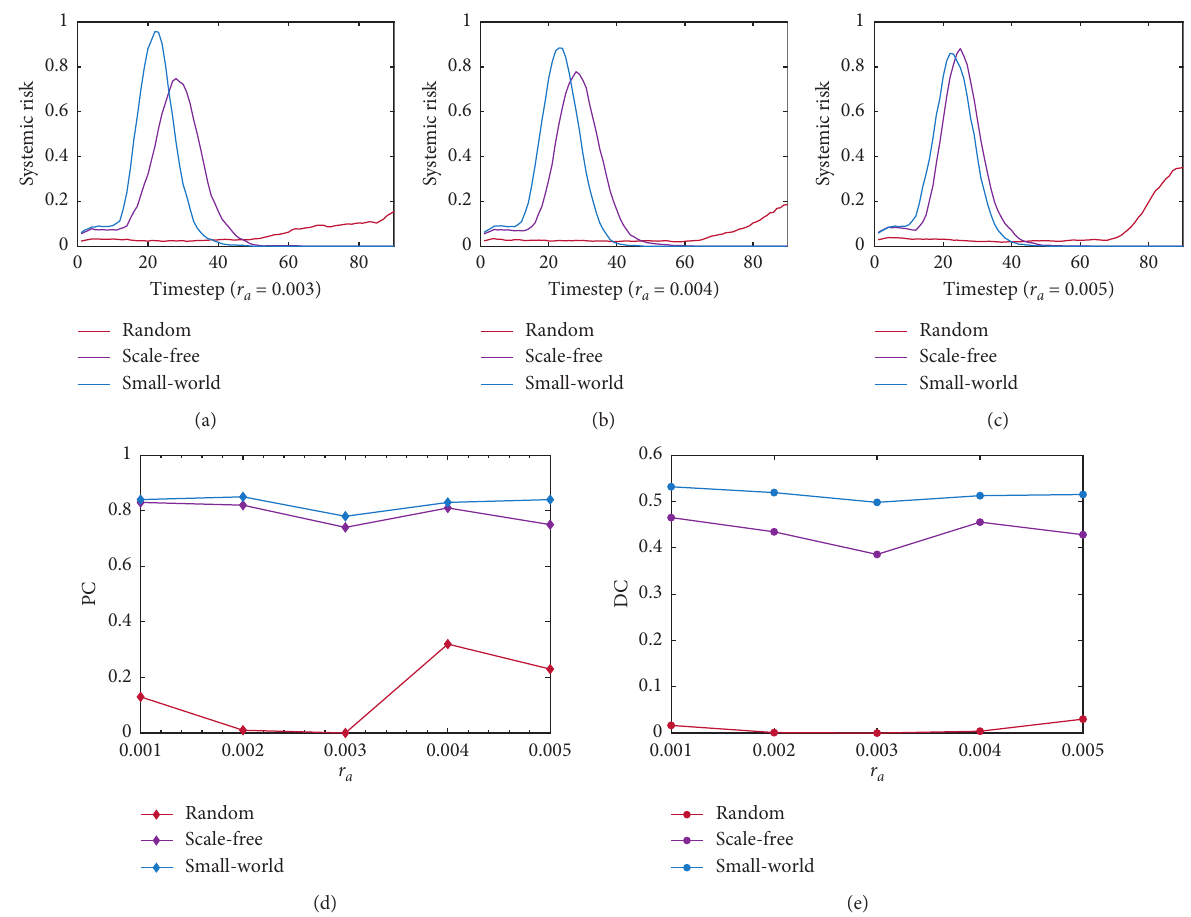
Figure 7: Evolution results of the diverse interbank networks under different r